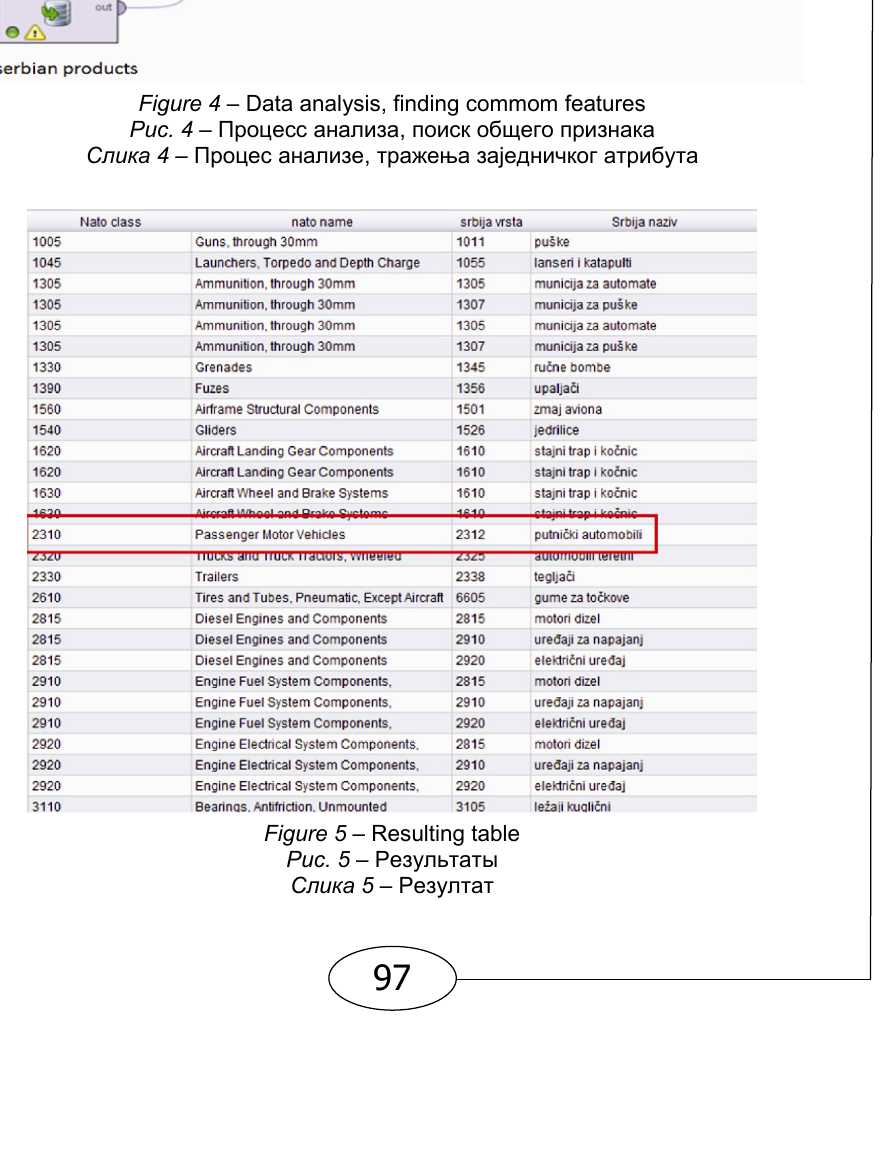
Figure 5 – Resulting table Рис . 5 – Результаты Слика 5 –